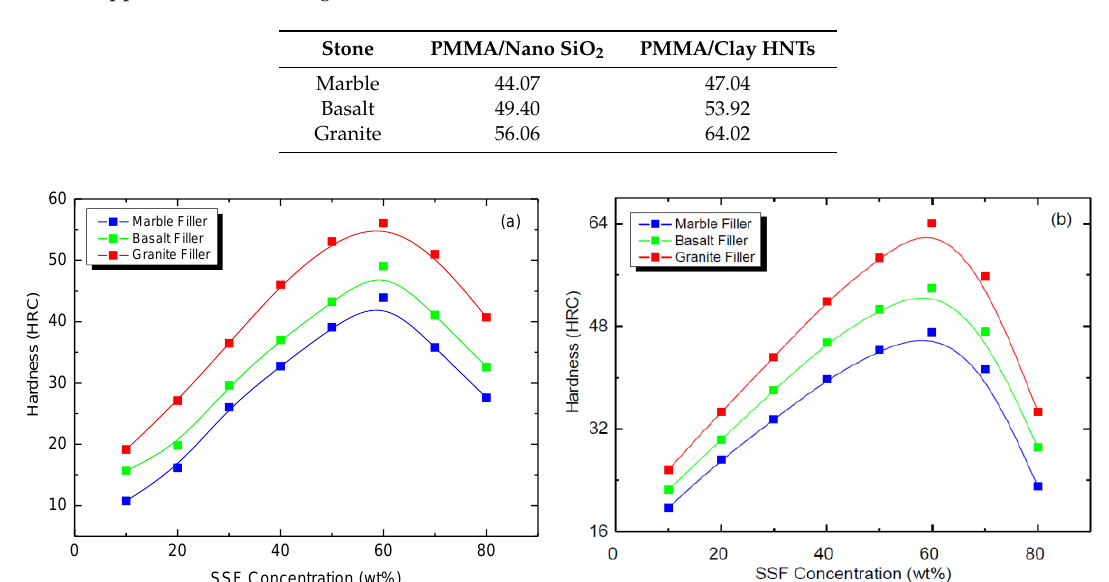
Figure 4. Effect of SSF concentration on the Rockwell hardness of acrylic solid surface nanocomposites ( a ) PMMA/SiO 2 /SSF and ( b ) PMMA/clay HNTs/SSF.